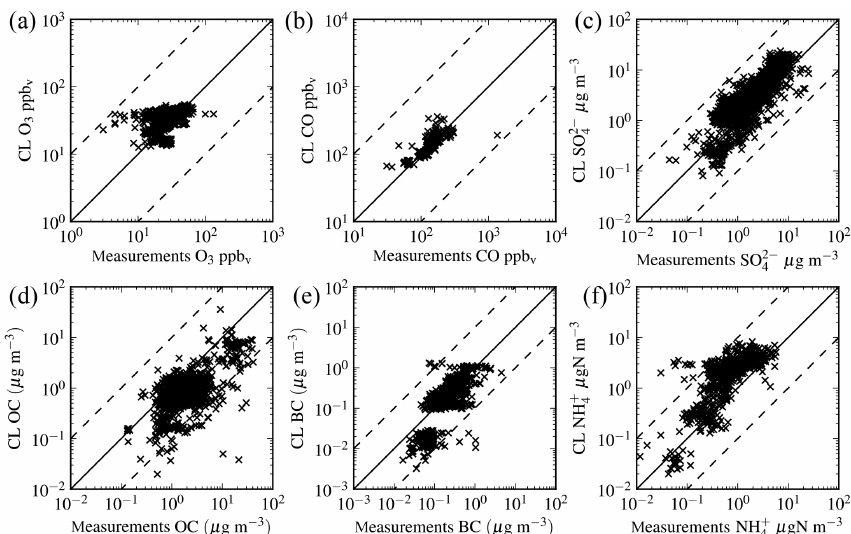
Figure 3. Comparisons of annual average surface model results versus observations per model grid (see Fig. S5 for station locations) for (a) O 3 , (b) for CO, (c) SO 2 − , (d) OC, (e) BC, and (f) NH + . The continuous line denotes the 1:1 slope and the dashed lines the 10:1 and 4 4 1:10 slopes. Table 1. Statistics of comparison of model (CL simulation) vs. observations and fine-resolution simulation (CL-fine) vs. observations (cor- responding to pollutant concentration scatter plots shown in Figs. 3 and S2). No. pairs shows the number of pairs used for the comparison. Meas and Model are means of all gridded data that are used for the comparisons (as described in Sect. 3.2). R is the calculated correlation between the measured and the modeled data. NMB stands for normalized mean bias of the model against the measurements. C stands for the CL simulation (6 ◦ × 4 ◦ ) and F stands for the CL-fine simulation (3 ◦ × 2 ◦ ). The units are ppb for gases (O 3 , CO) and µg m − 3 for aerosols (SO 2 − , OC, BC, NH + ). 4 4 No. pairs a Meas Model R NMB b (%)